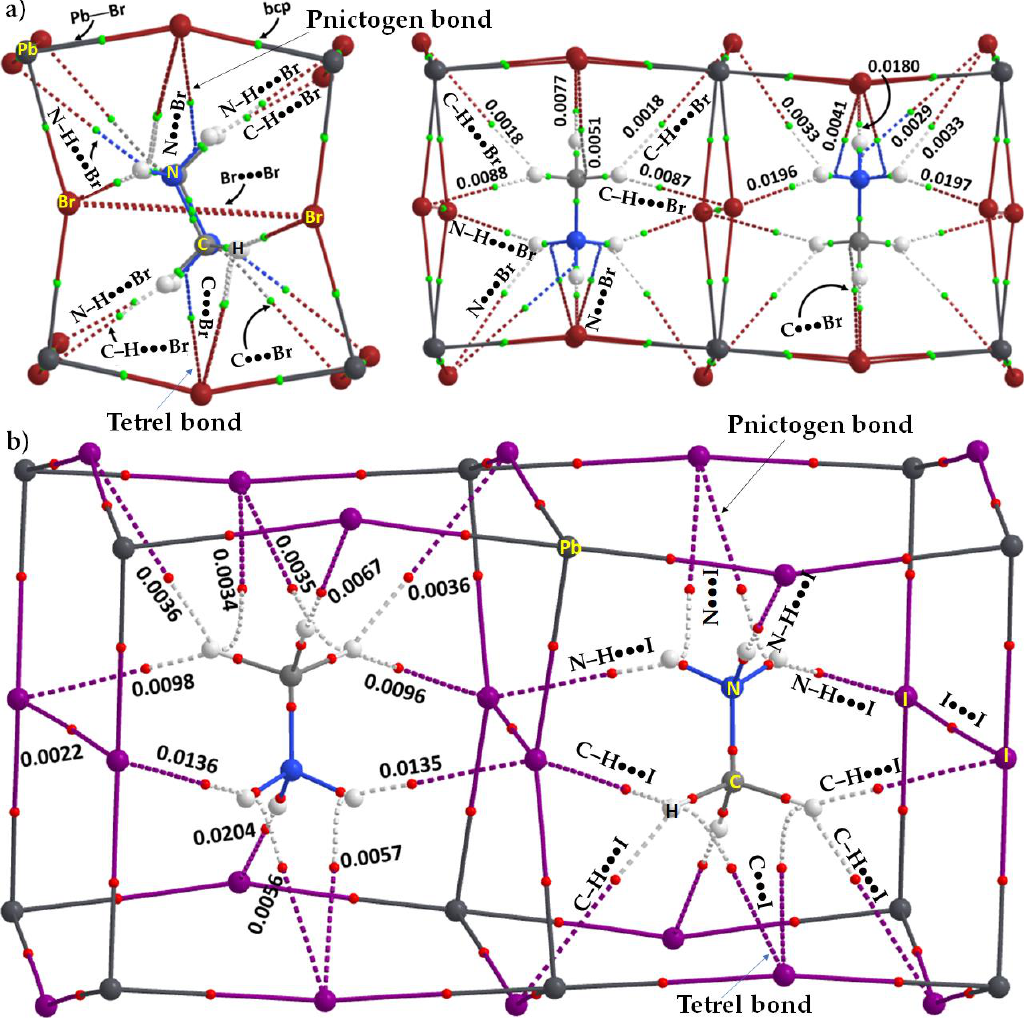
Figure 4. ( a ) QTAIM-based molecular graph and (3, – 1) bond critical point charge density topologies ( ρ b ) for ( a ) o-CH 3 NH 3 PbBr 3 and ( b ) o-CH 3 NH 3 PbI 3 , obtained with PBE/DZP, very similar to what reported by us elsewhere [25,26]. The PBE relaxed geometry for o-CH 3 NH 3 PbBr 3 and the neutron diffraction geometry (T ≈ 100 K [89]) for o-CH 3 NH 3 PbI 3 were used. Atoms: iodine — purple, carbon — dark-grey, nitrogen — deep-blue, hydrogen — white-grey; bond paths are shown as solid and dotted lines in atom color; (3, – 1) bond critical points are shown as tiny blue and red spheres between bonded atomic basins. Dotted lines (bond paths) indicate the presence of non-covalent interactions between atoms that are liked with each other. Values of ρ b are in a.u. Because the (N)H···I and (C)H···I hydrogen bonds in o-CH 3 NH 3 PbI 3 are longer than those in o-CH 3 NH 3 PbBr 3 , the QTAIM results suggest the formation of a single (N)H···I hydrogen bond by each H atom of the – NH 3 group and at least two (C)H···I bonds formed by each of the H atoms of – CH 3 group of MA (Figure 4b). The inward curvature of the bond paths between N or C in MA and the nearest I sites indicates that the N···I and C···I pnictogen- and tetrel-bonds in o-CH 3 NH 3 PbI 3 are dispersive and weak. The nature of the bond path topologies associated with these interactions is very similar to that found for o- CH 3 NH 3 PbBr 3 (see Figure 4a,b). The charge density values depicted in Figure 4 suggest that they are very small at the bcps and are typical of non-covalent interactions ( ρ b < 0.05 au). It is also apparent that ρ b at the N···I and C···I bcps are smaller than those at the (N)H···I and (C)H···I bcps, confirming that first two are weaker than the last two. These analyses